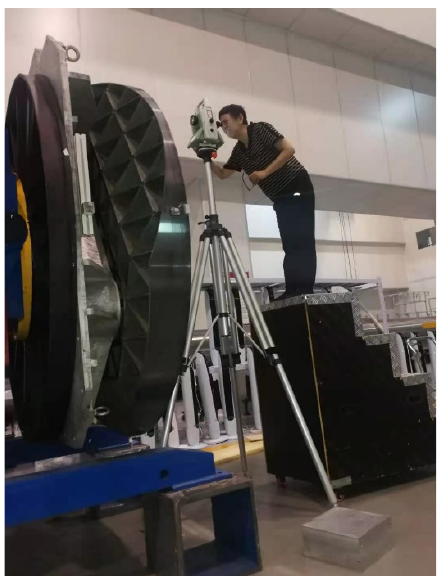
Figure 17. Detected rigid displacement and tilt angle of the mirror body using a theodolite.